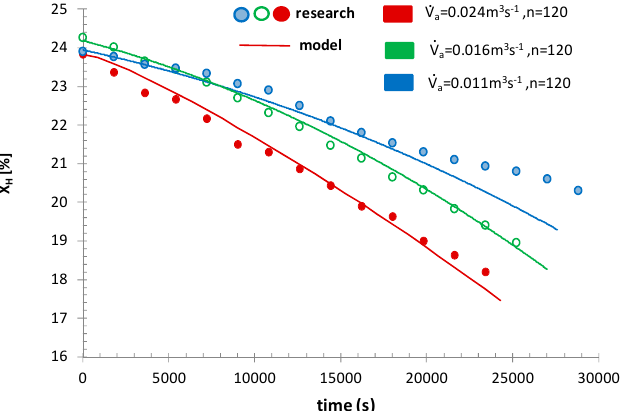
Figure 2. Comparison of the calculated and experimental values of honey moisture as a function of time X H ( τ ), for n = 120 rpm.